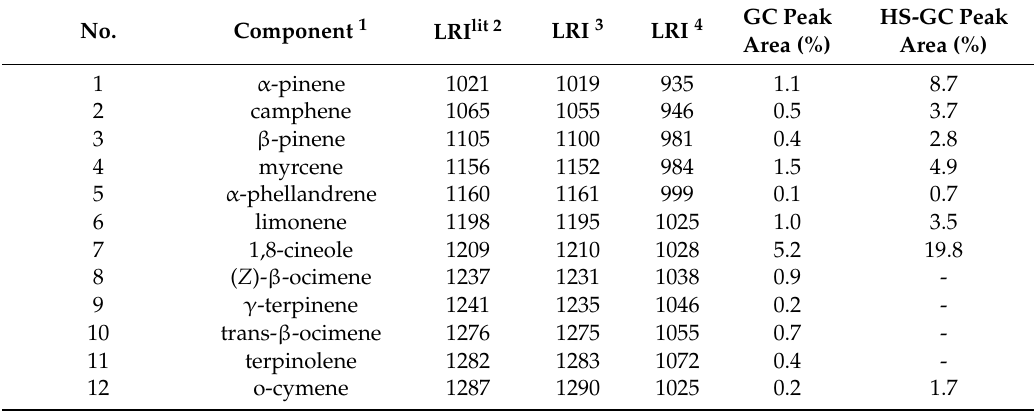
Table 1. Chemical composition (%) of Lavandula × intermedia cv. “Grosso” essential oil (LEO).